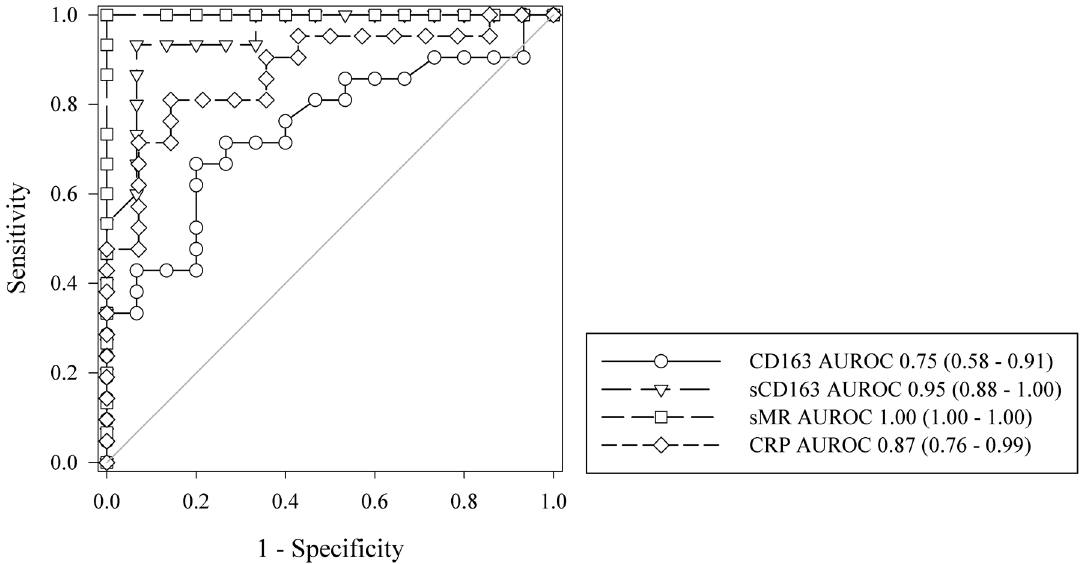
Figure 2. Receiver operating characteristic curve analysis and the ability to discriminate between septic patients and non-septic patients at ICU admission. Area under the receiver operating characteristic curve (AUROC) is shown for monocyte-bound CD163, sCD163, sMR, and plasma CRP. Numbers in parentheses are 95% confidence intervals. specificity. CRP at a cut-off value of 91.8 mg/l had 80% sensitivity and 86% specificity.